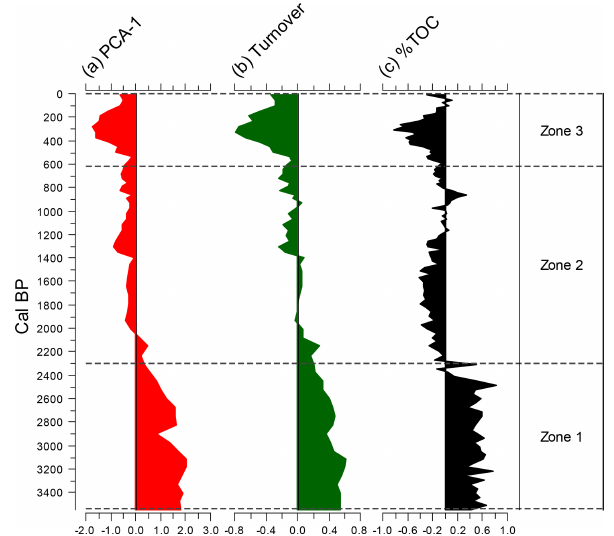
Figure 5. Ordination, compositional turnover, and TOC trends shown as deviations around the